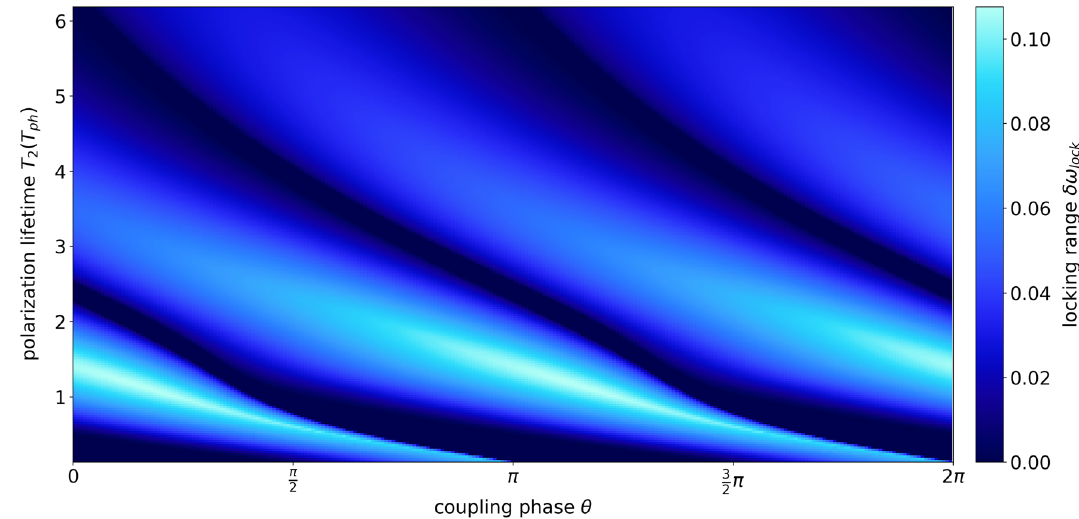
Figure 7. Color coded locking range δω lock as a function of the coupling phase θ and the polarization lifetime T 2 on the intervals [0.1, 8] T and [0, 2 π ] θ . Other parameters are �ω = 3 , p = 2 , K = 0.1 , τ = 10 2